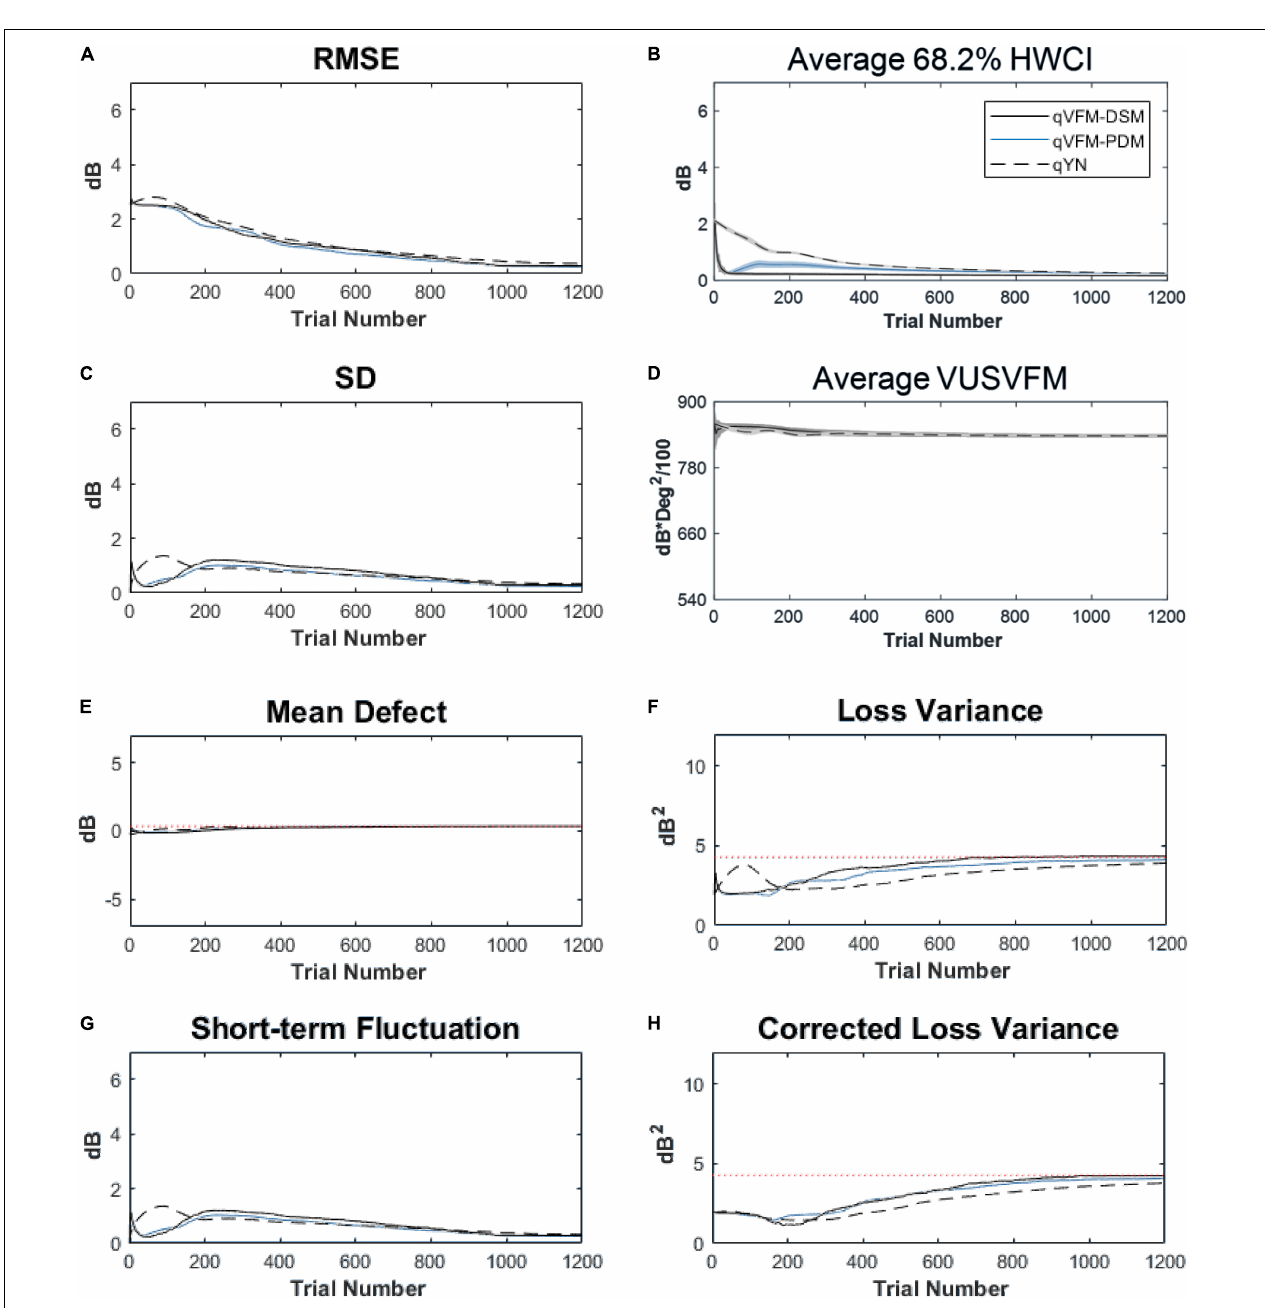
FIGURE 3 | Performance I of the qVFM-DSM, qVFM-PDM and qYN methods in estimating VFM of the simulated scotoma observer across 200 runs. (A) Average root mean squared error, (B) Average 68.2% HWCI of the estimated VFM, (C) Average standard deviation, (D) Average volume under the surface of the VFM (VUSVFM), (E) Mean defect, (F) Short-term fluctuation, (G) Loss variance, and (H) Corrected loss variance. Results from the qVFM-DSM and qVFM-PDM methods are shown in solid black and blue lines, and results from the qYN method are shown in dashed lines. The true values of the global indices are shown in red dotted lines. For panels (B,D) , shaded regions represent ± 1 SD of the corresponding